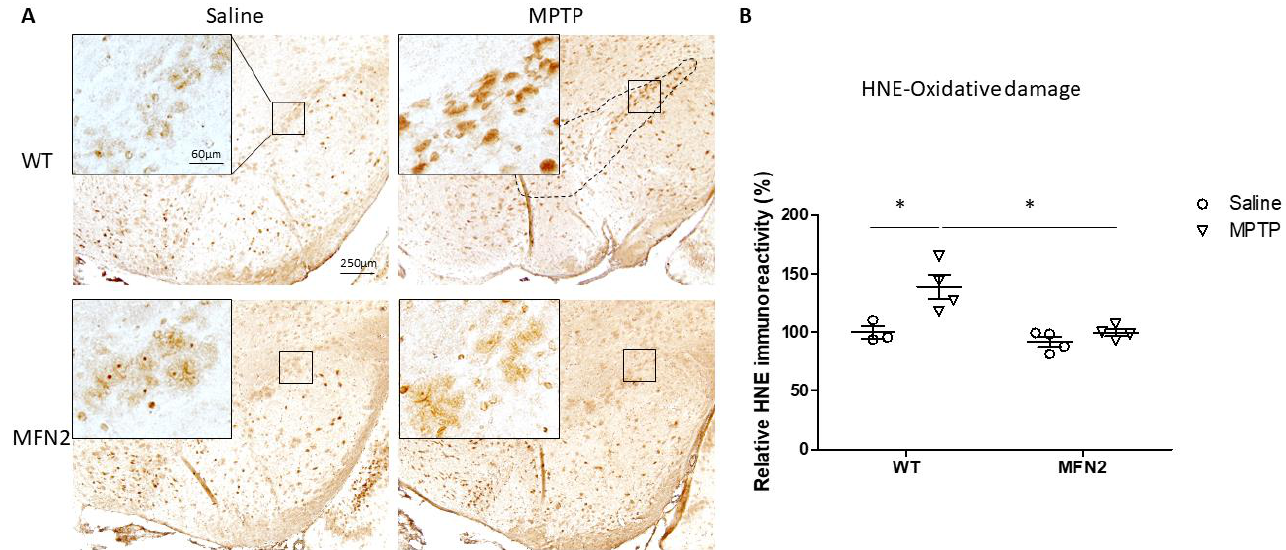
Figure 3. Mfn2 overexpression alleviated MPTP-induced oxidative stress in the SN. Fixed half brains of MPTP- or saline- treated mice were prepared, as shown in Figure 2A, and immunostained for 4-HNE. Representative pictures ( A ) and quantification ( B ) of relative 4-HNE immunoreactivity in the SN (dashed line) are shown. ( n = 4; * p < 0.05 compared to the control) .